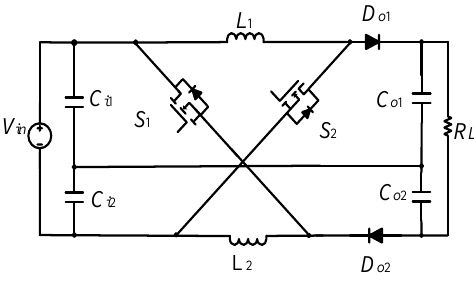
Figure 1. Dual switch step-up DC / DC converter.